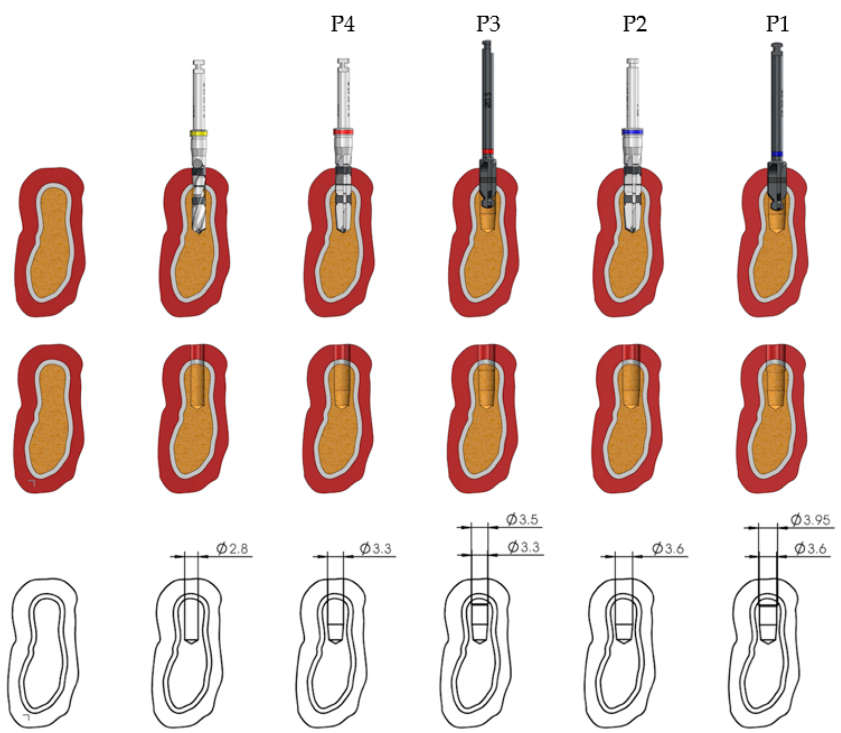
Figure 3. Surface morphology of area of the implant in contact with the bone, and the diameter in each site preparation for 4.0 mm diameter implants.